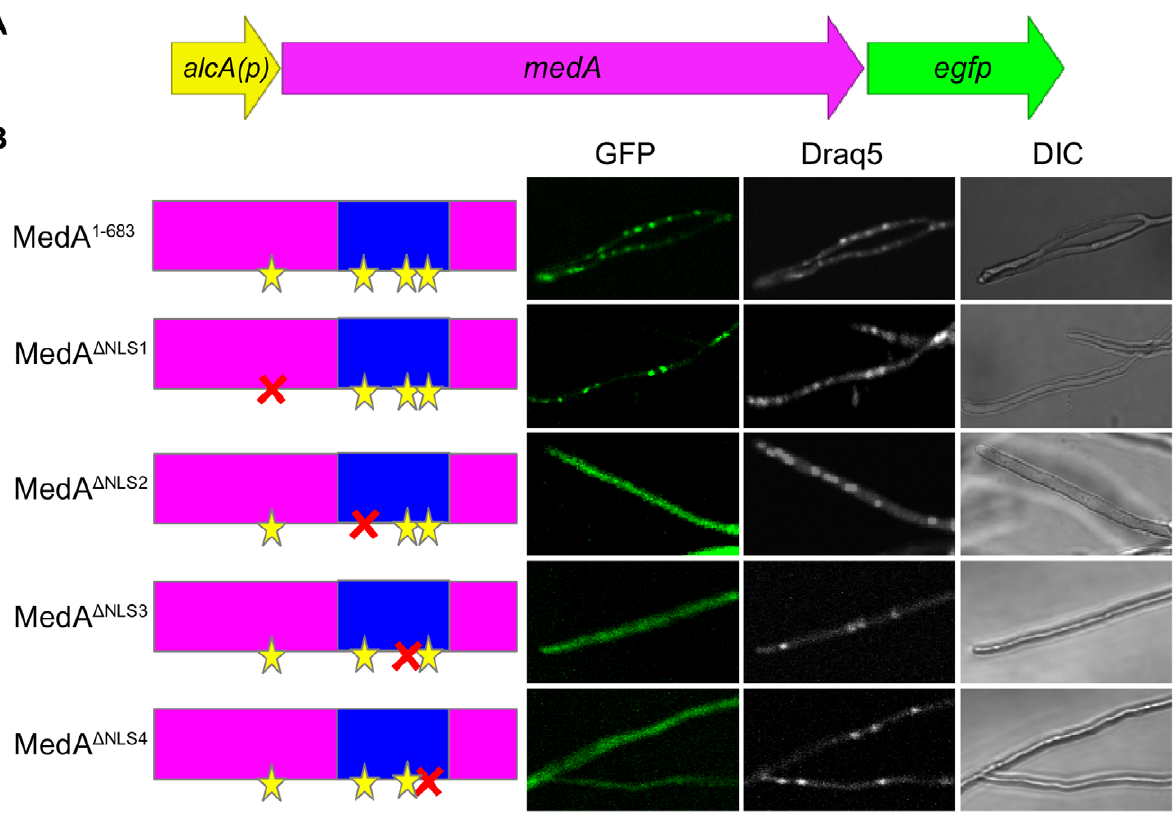
Figure 3. Deletion of putative NLS sequences in A.fumigatus MedA. (A) Schematic overview of the medA-egfp gene fusions expressed by alcA promoter in the Af293 wild type strain. (B) The effect of deletion of the MedA NLS sequences on the subcellular localization of MedA-EGFP fusion proteins in A. fumigatus Af293. Nuclei were stained by Draq5 while mycelia were analyzed by light microscopy. Left, center, and right columns show the GFP, Draq5, and DIC (Differential Interference Contrast), respectively. The names of the deleted NLS and the depiction of the different MedA-EGFP fusion proteins are indicated on the left side. The putative NLSs 1–4 are indicated by yellow stars while the deleted NLS is indicated by red X. The minimal nuclear localization domain, MedA 346–557 is indicated by the blue